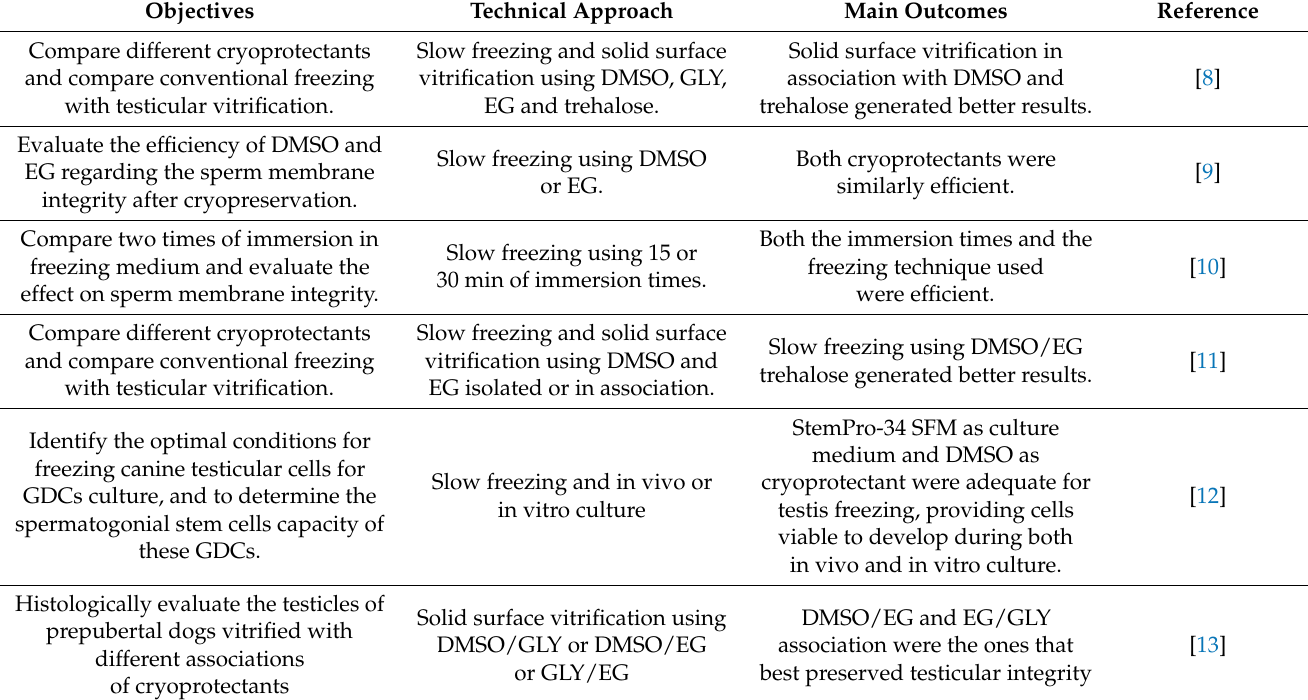
Table 1. Papers addressing testicular cryopreservation in